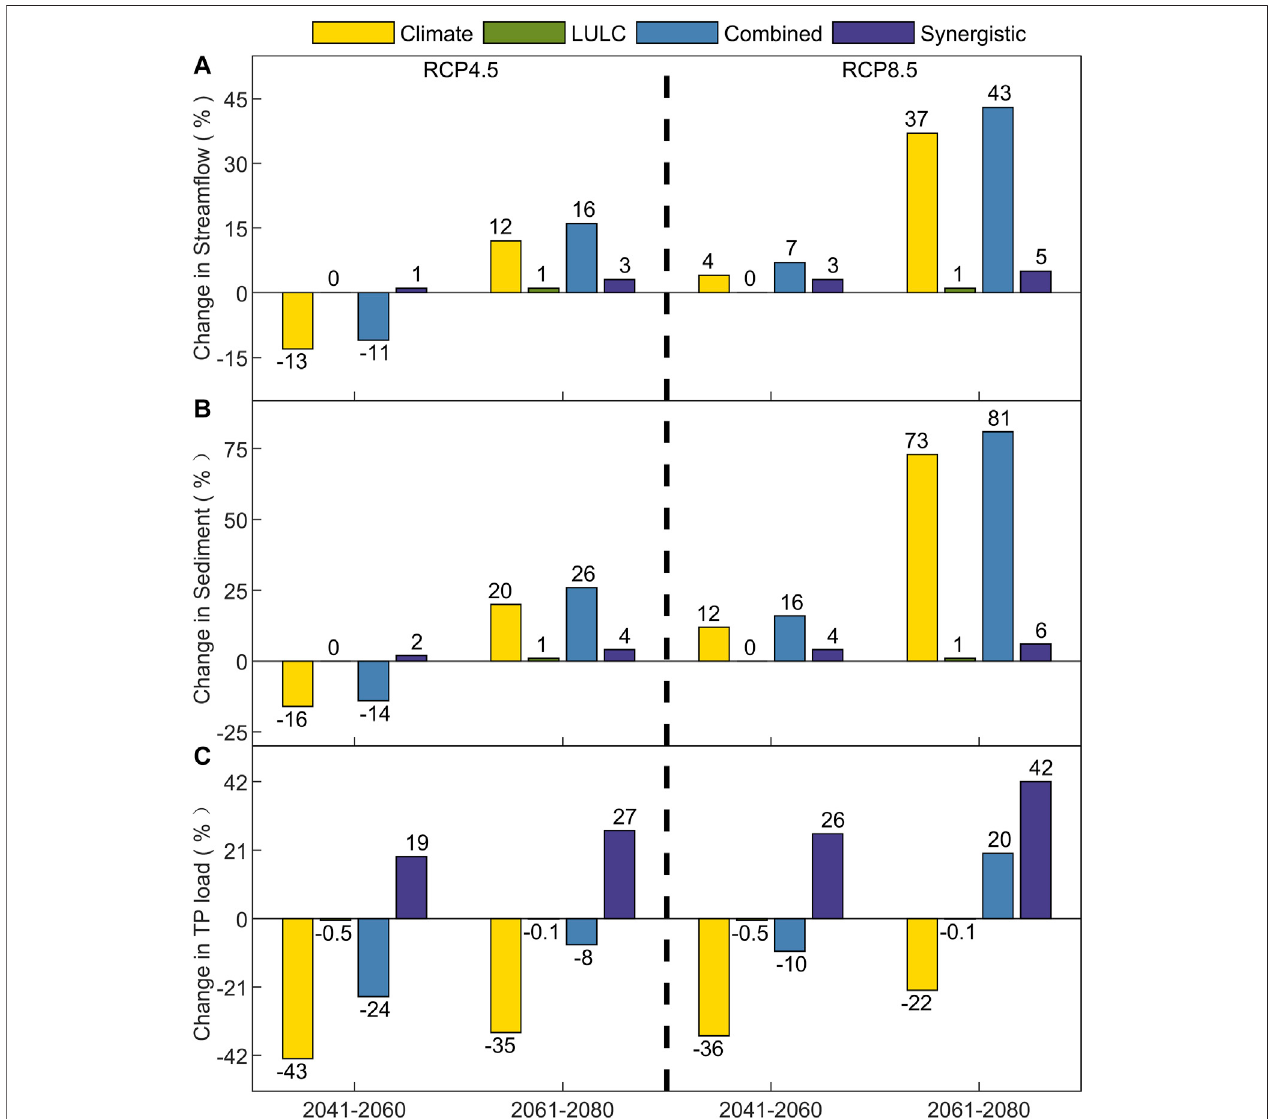
FIGURE 5| The individual and combined impacts of climate change and land use on the Coef fi cient of Variation of monthly temperature, precipitation, stream fl ow, sediment, and TP under various scenarios (X-axis represents the scenario number corresponding to Table 4 ).